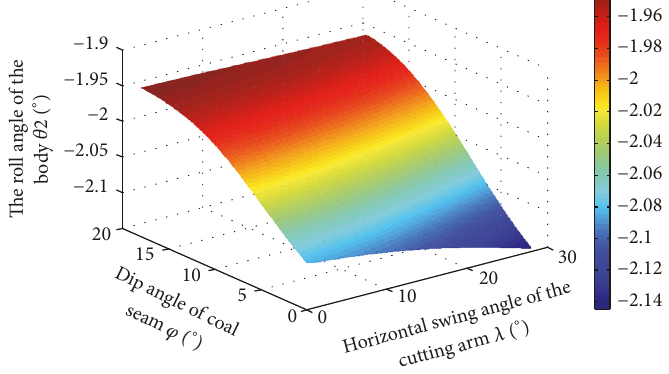
(c) The relationship of 𝜃 2 , horizontal swing angle of the cutting arm, and the dip angle of coal seam Figure 15: The response results of the roll angle of the body 𝜃 2